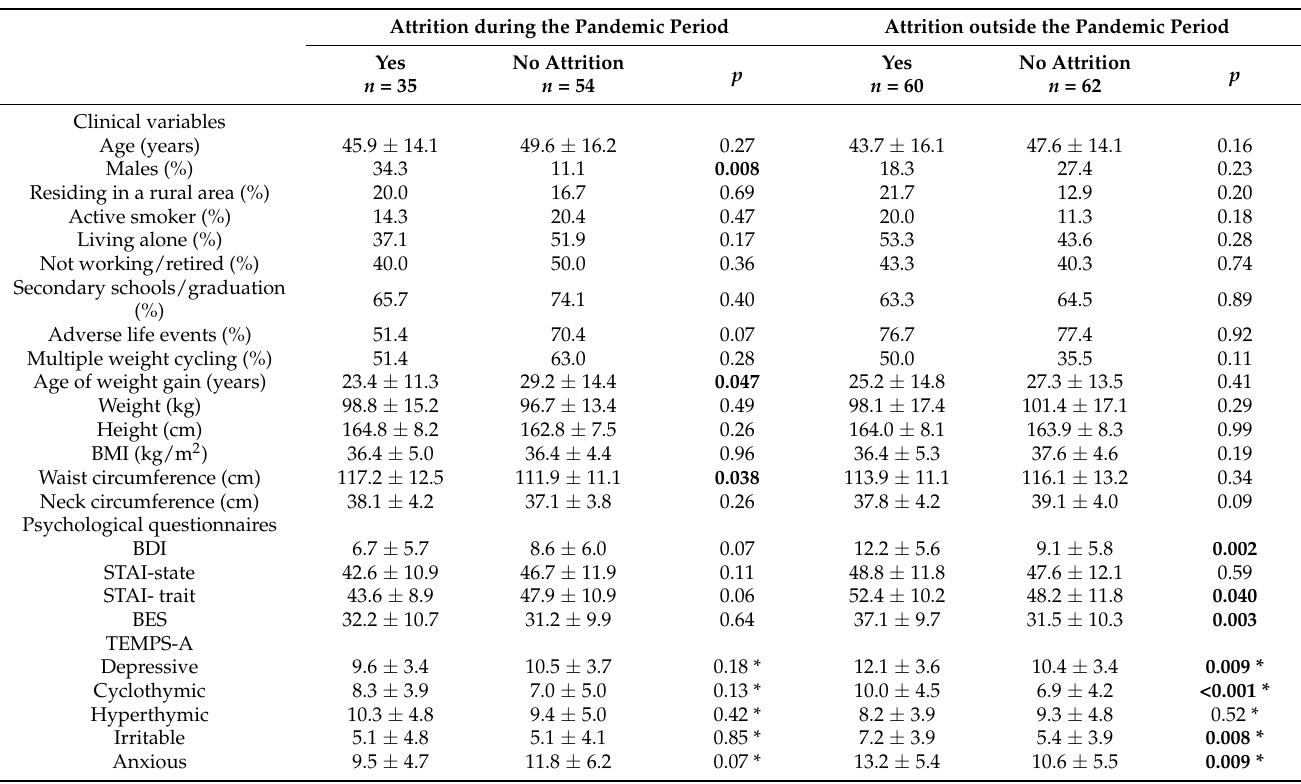
Table 2. Attrition by the period of attendance to the obesity unit.